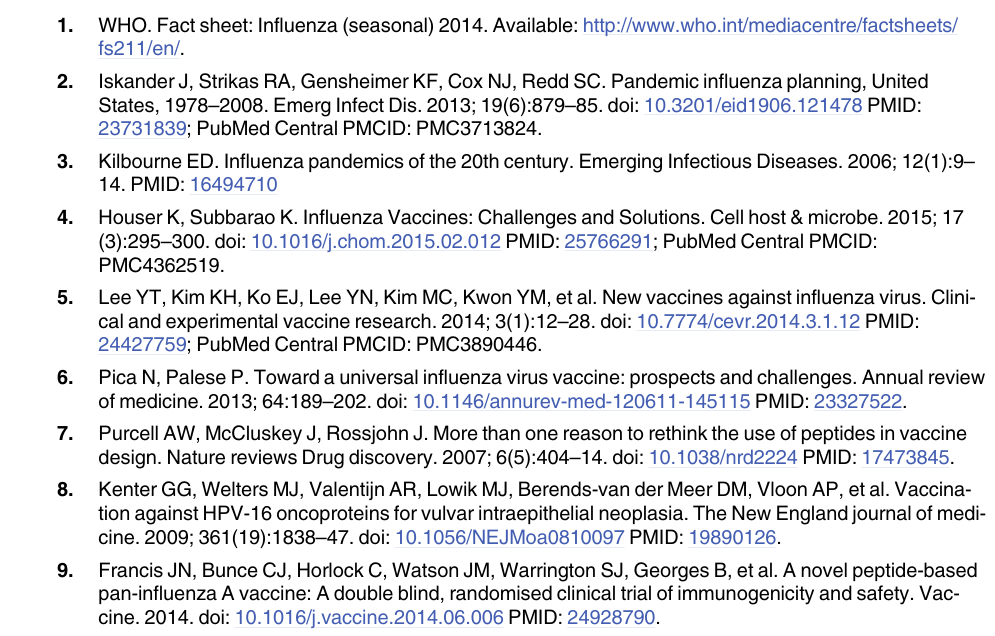
S2 Table. Heat map representation of Table 1. FP binding scores of selected HLA-A (cid:1) 0201 peptides. S3 Table. GILG, FMY and NML specific CD8 + T cell responses after stimulation with CPLs in in vitro and ex vivo screening models. S4 Table. Heat map representation of Table 3. FP binding scores HLA-A (cid:1) 0301 peptides.